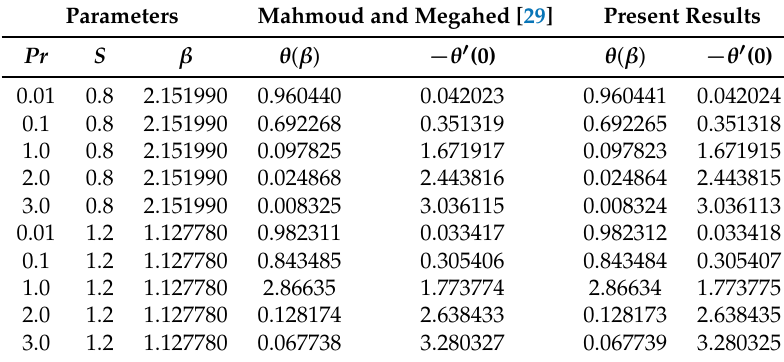
Table 3. Comparison of values of surface temperature and wall temperature gradient with increasing values of Pr , S and β when φ = A 3 = A 4 = M = 0, and h = − 0.10.